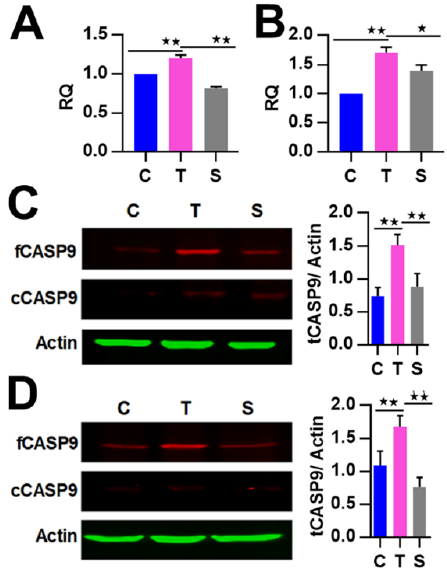
Figure 3. The regulation of CASP9 by NF- κ B. ( A , B ) Expression of CASP9 mRNA in HeLa cells ( A ) and HepG2 cells ( B ). The data are presented as the means ± SEM from three independent experiments with three replicates in each test. GAPDH was used as the endogenous control to normalize CASP9 expression. Relative quantification (RQ) is the CASP9 expression normalized to GAPDH expression in each sample and presented relative to the control cells. ( C , D ) Expression of CASP9 protein in HeLa ( C ) and HepG2 ( D ) cells. The signal intensity of full-length CASP9 (fCASP9) and cleaved CASP9 (cCASP9) proteins were quantified with Image J software and normalized to that of the actin. The normalized signal intensity of fCASP9 plus that of cCASP9 was represented as normalized total CASP9 (tCASP9) signal that was visualized by a histogram at the right of blot images. The data are presented as the means ± SD from three independent experiments. C, control cells; T, TNF α -treated cells; S, RelA siRNA and TNF α co-treated cells. The significance of the di ff erence was analyzed by one-way ANOVA. * p < 0.05; ** p < 0.01.